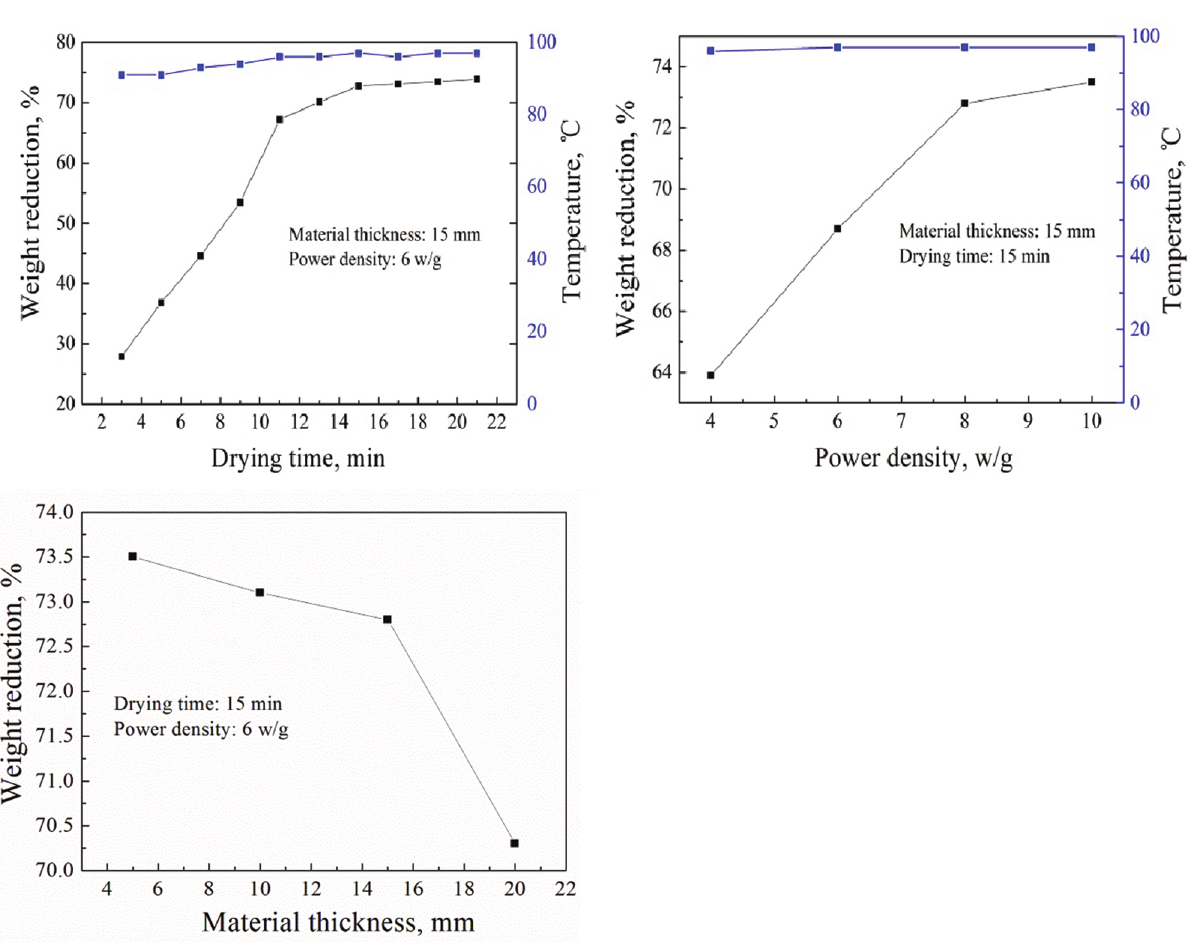
Figure 2: Effects of drying time, power density and material thickness on the weight reduction.